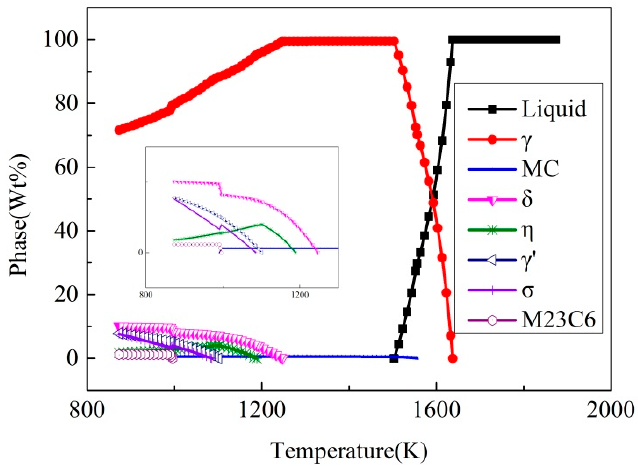
Figure 4. Phase fraction of the superalloy during equilibrium solidification.